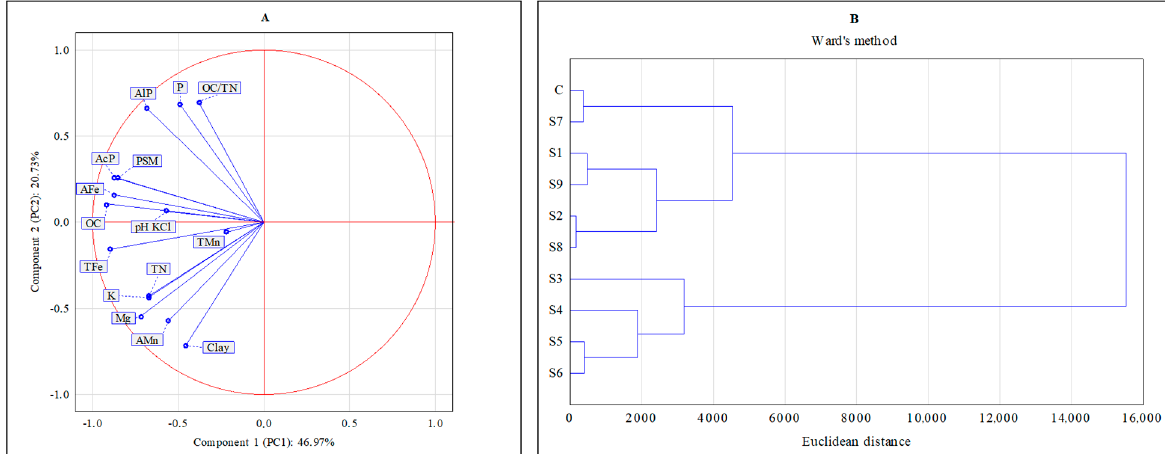
Figure 7. Configuration of variables in the system of the first two axes PC1 and PC2 of principal components ( A ); cluster analysis ( B ). In autumn.